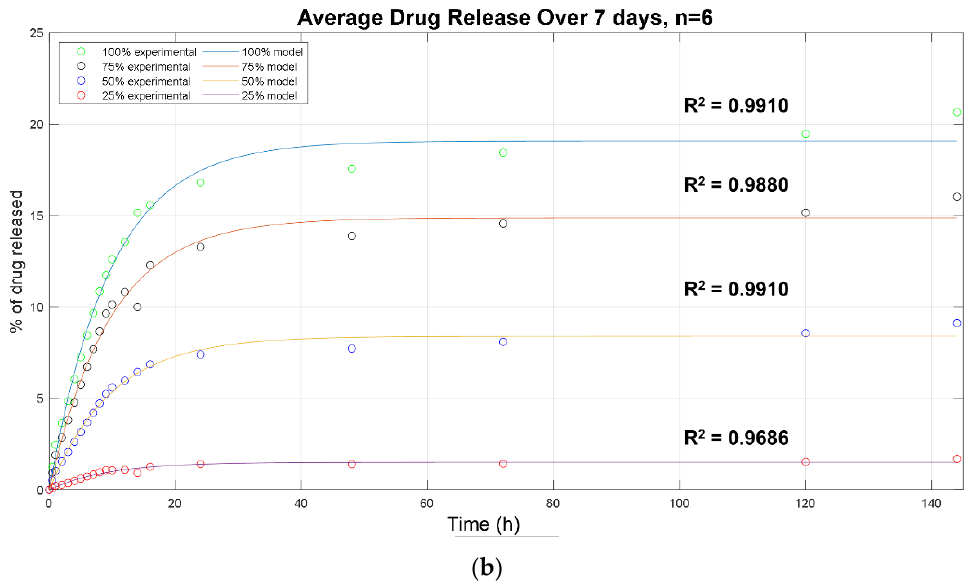
Figure 4. Acetaminophen release data from NFC/PVA film formulation ( n = 6). Experimental measurements of drug release using HPLC are indicated by colored circles. Modeled releases using Equation (2) are represented by solid lines and labeled with their respective R 2 values. Plots were produced in MATLAB. ( a ) 24-h release ( b ) full 144-h (6 days) release. Table 3. Values related to the burst release of each formulation, determined by fitting Equation (2) to the experimental data in MATLAB. Sample